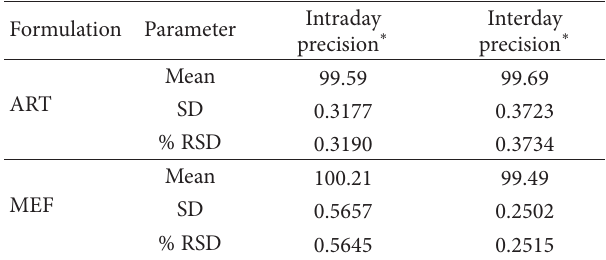
T 7: Results of intermediate precision. Formulation